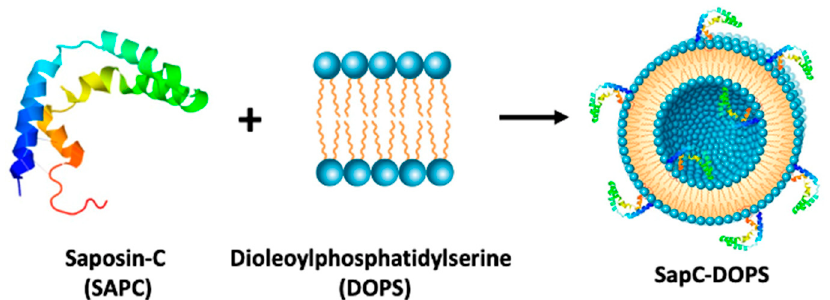
Figure 2. Makeup of SapC-DOPS. Nanodrug SapC-DOPS is composed of a small lysosomal and multifunctional glycoprotein, SapC (Saposin C) [110], embedded in the membrane of a microvesicle rich in negatively charged phospholipids, dioleoylphosphatidylserine or 1,2-dioleoyl-sn-glycero-3-phosphoserine (DOPS). Figure 2 is adapted from [111].